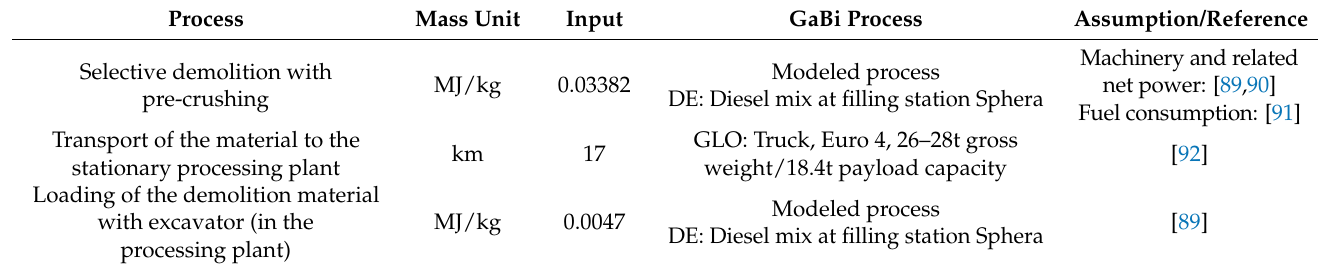
Table 1. Inventory